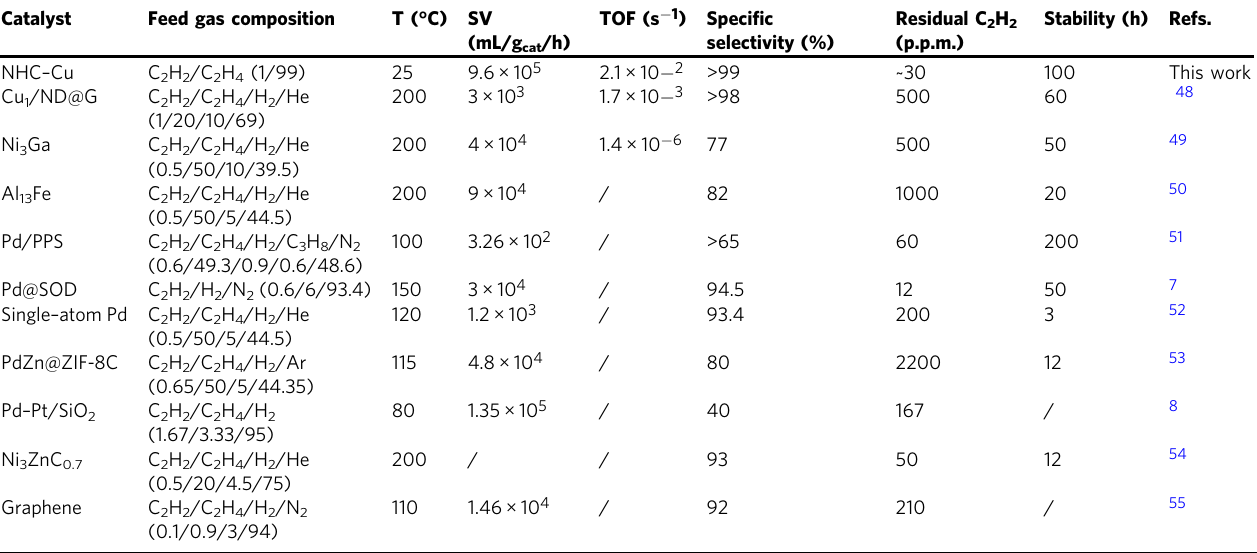
Table 1 Comparison of acetylene semihydrogenation performance between EAH of NHC – Cu and the reported TAH of